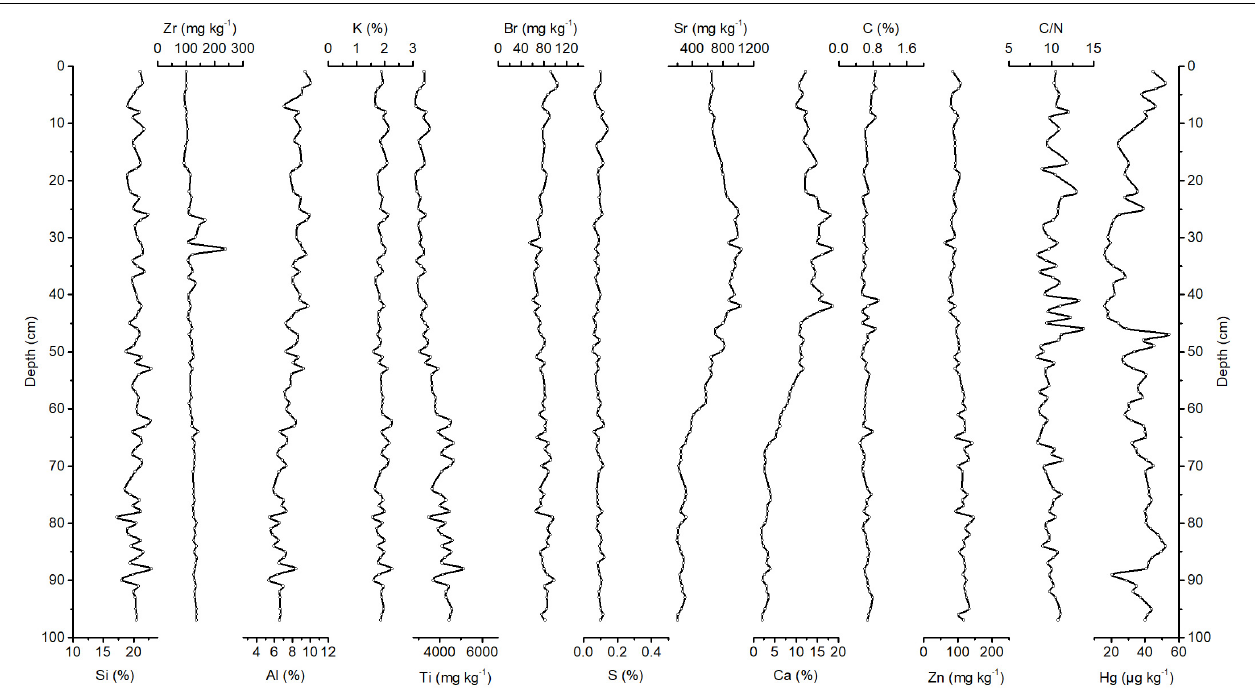
FIGURE 4 | Downcore records of Si, Zr, Al, K, Ti, Br, S, Sr, Ca, C, Zn, and Hg concentrations and C/N ratios of Amazon Fan